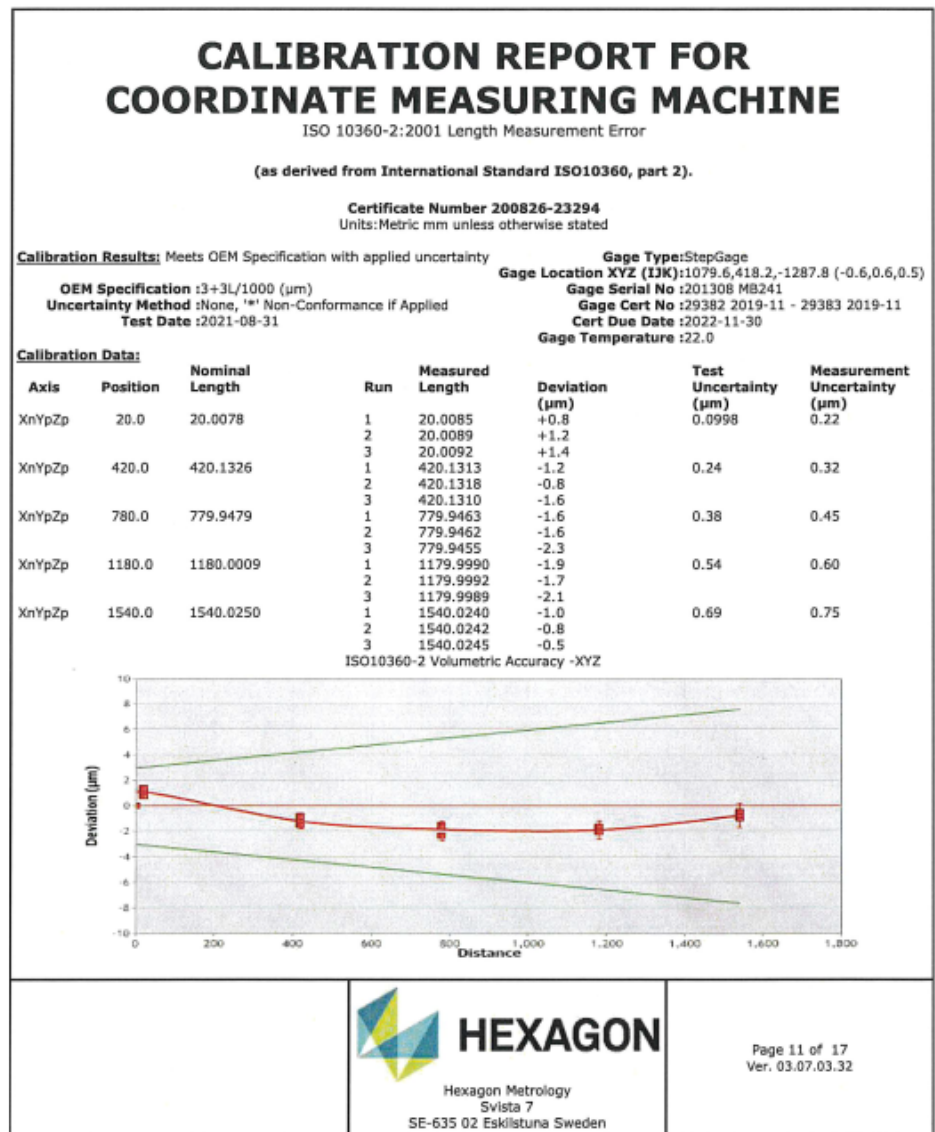
Figure 13. Calibration report for Hexagon DEA Global CMM. Test date 31 August 2021.